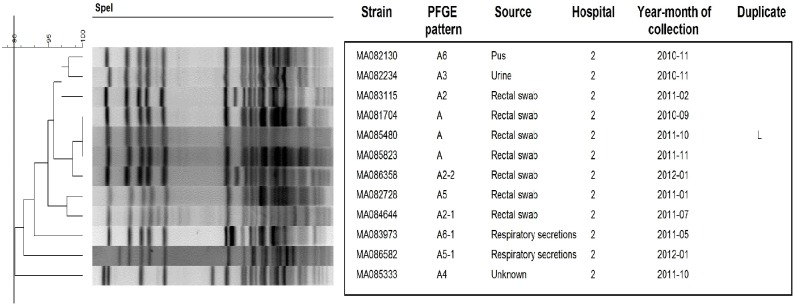
PFGE patterns of S. marcescens KPC strains (n = 12).One strain (MA088423) was untypable by SpeI. Black line in dendrogram represents percentage similarity cut-off. Box represents the main cluster within the species. Patients with more than one bacterial strain carrying KPC gene were identified as duplicate, following the same nomenclature through all figures.